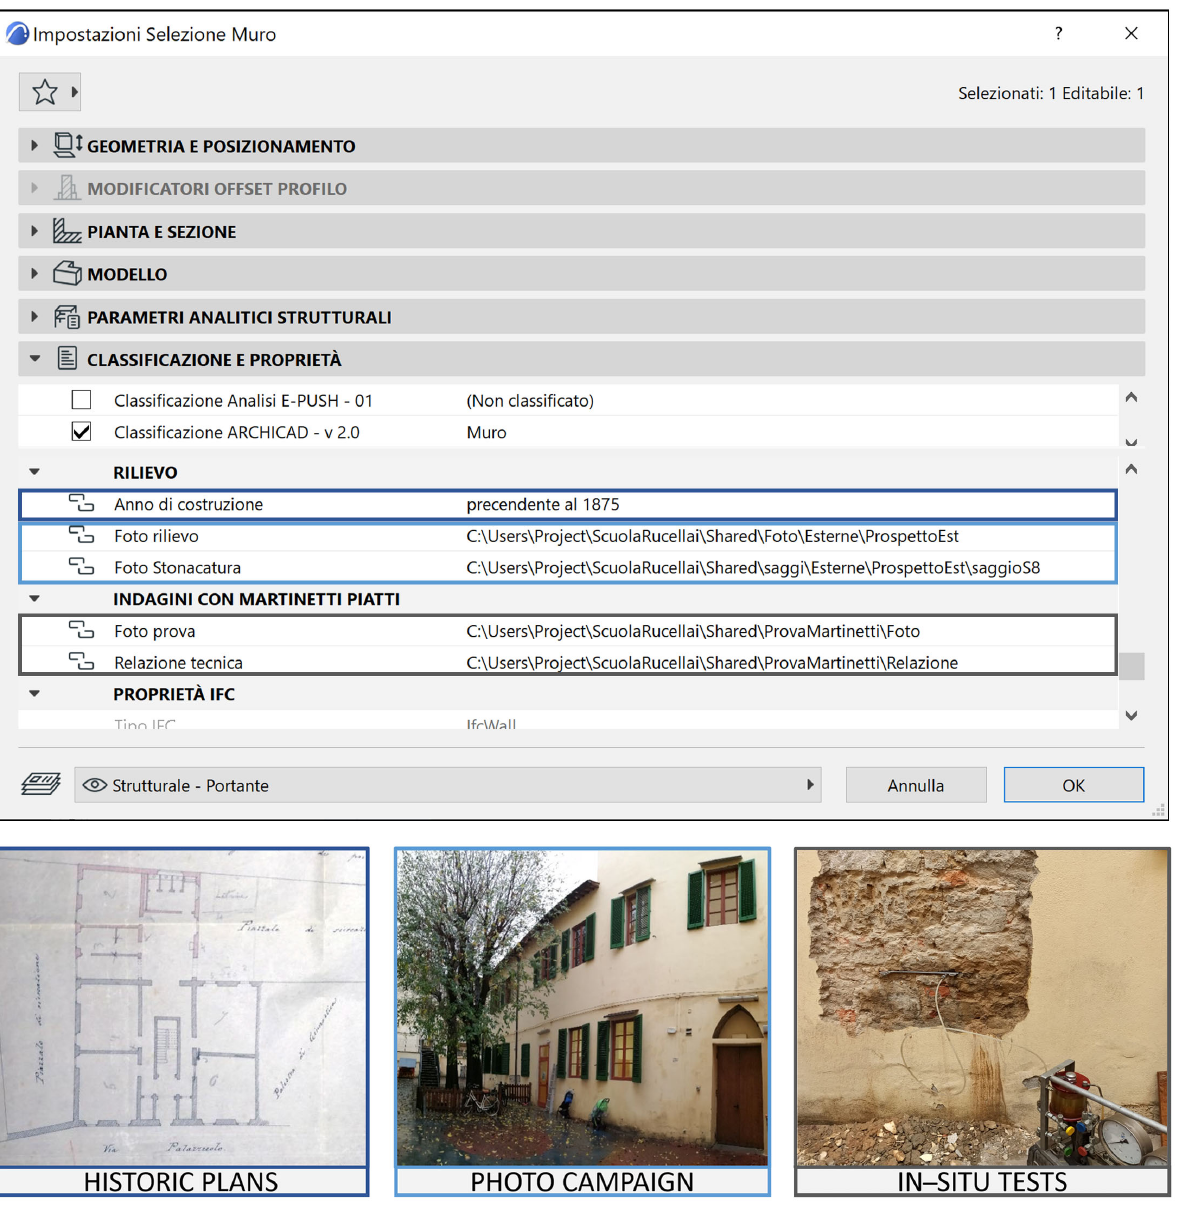
Figure 4. Informed Architectural Model of the Building in Archicad.